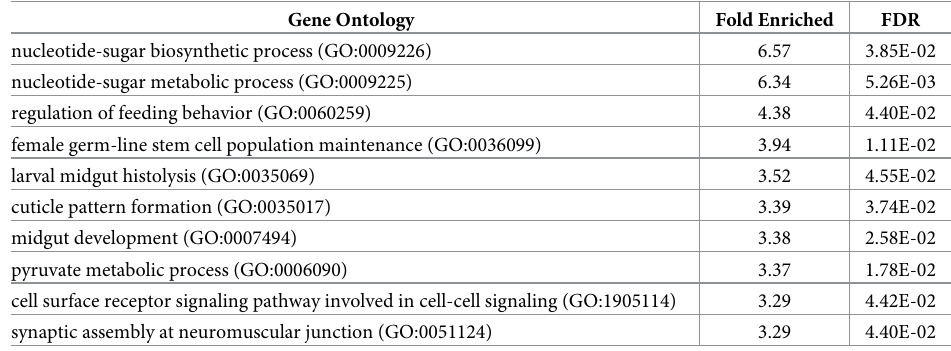
Candidate genes with an lfc of � 0.5 or � -0.5 were analyzed